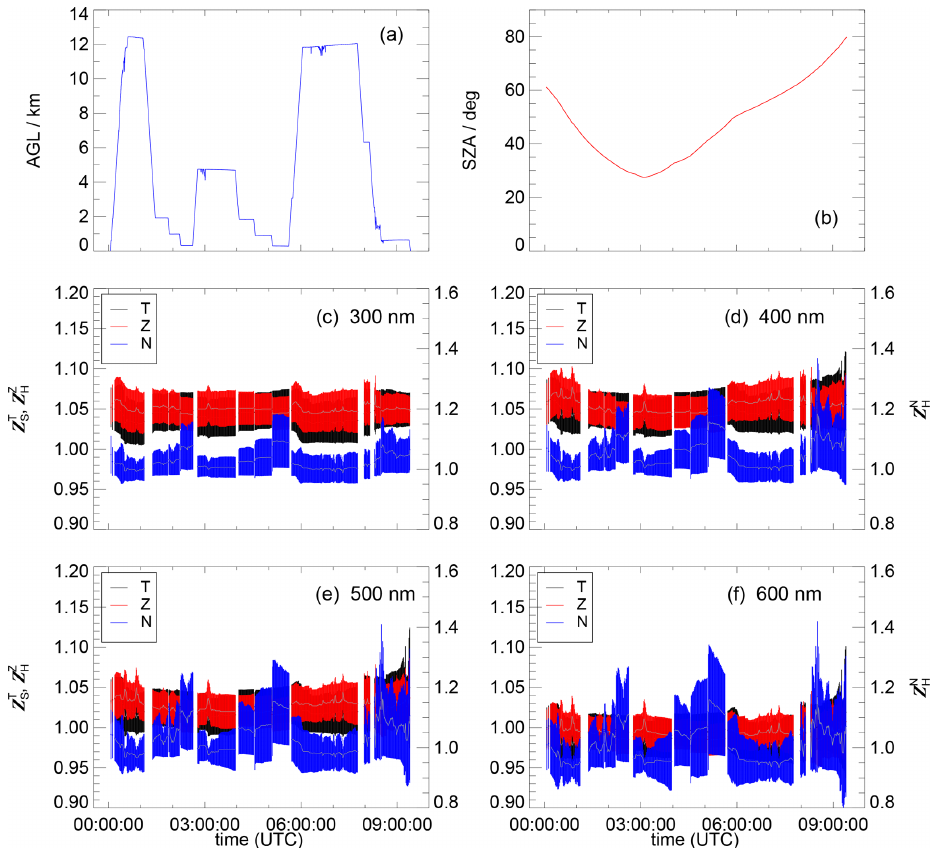
Figure 17. HALO flight example with a return flight from Taiwan to Japan on 30 March 2018 over the East China Sea (EMeRGe campaign). (a) Heights above ground (a.g.l.) and (b) solar zenith angles (SZAs). (c) – (f) Parametrized correction functions Z T (N) for selected wavelengths, with error bars indicating uncertainties (FLT configuration). For clarity, 1min averages are shown with grey overlays. The right-hand y axes refer to the Z N H